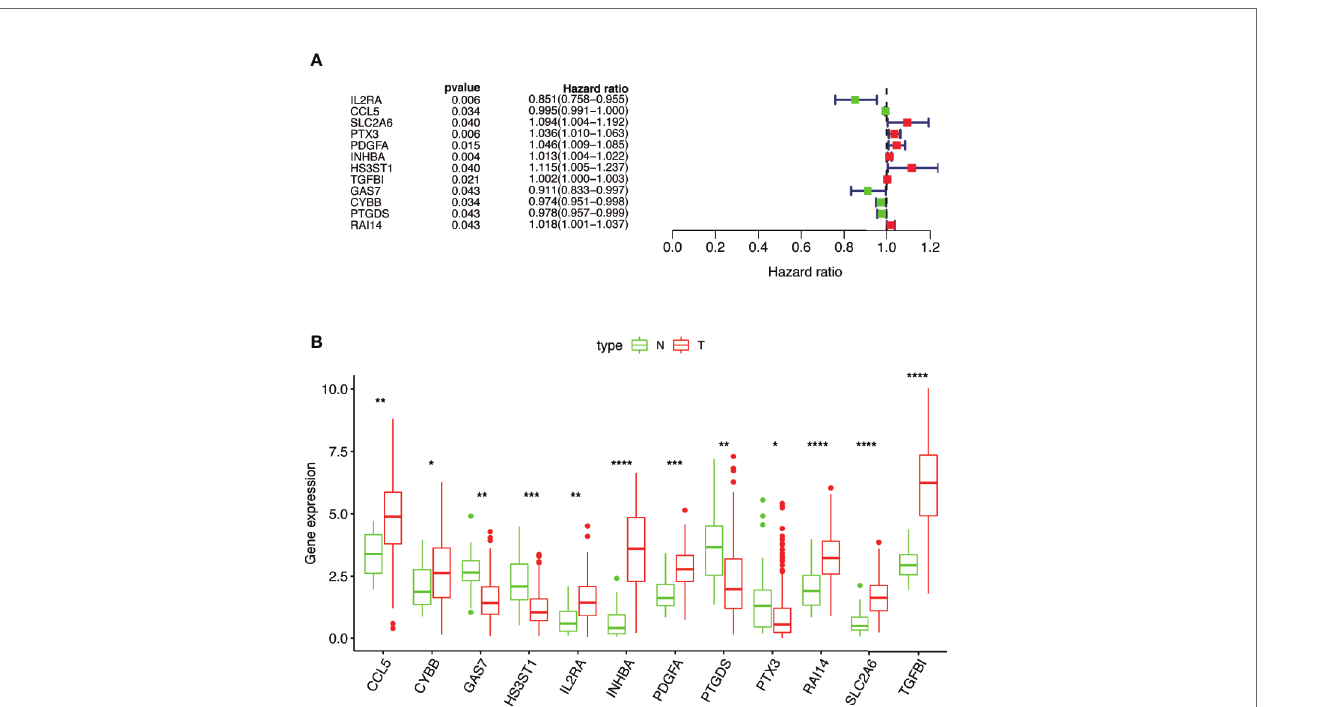
FIGURE 3 | Selection of 12 MGMs associated with the OS of HNSCC patients by univariate Cox regression analysis. (A) Univariate Cox regression analysis. Forest plot of 12 MGMs associated with survival. (B) Differential expression of the 12 MGMs between 24 tumor-adjacent tissues and 250 HNSCC tissues. Note: * P < 0.05,